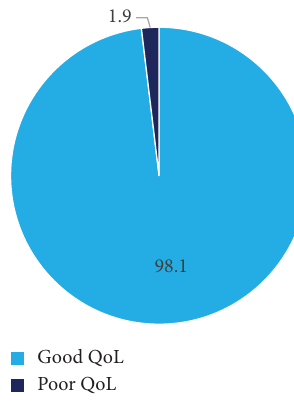
Figure 3: QoL of participants.